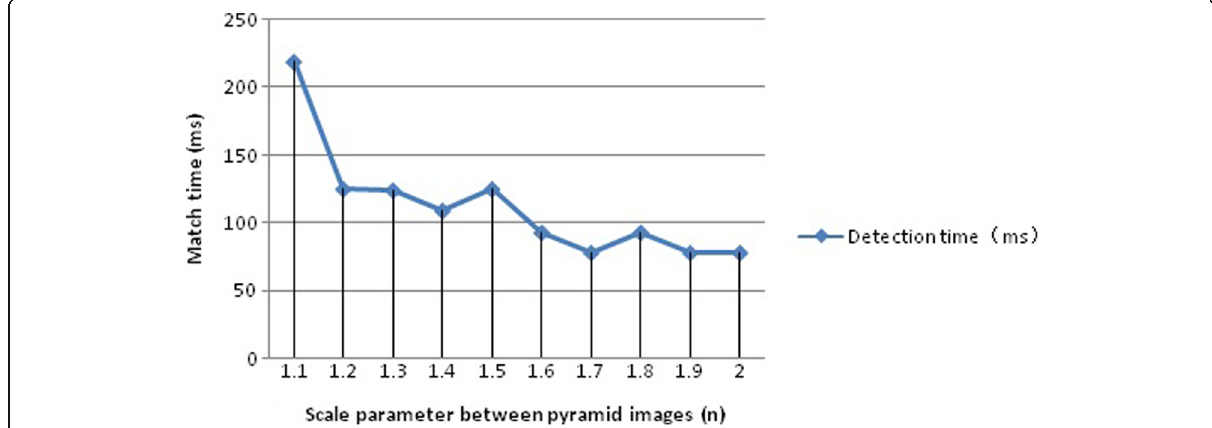
Fig. 26 Relationship between scale parameter variation and matching time between pyramid